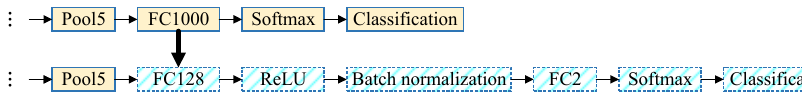
Figure 4. The modifications of the backbone.